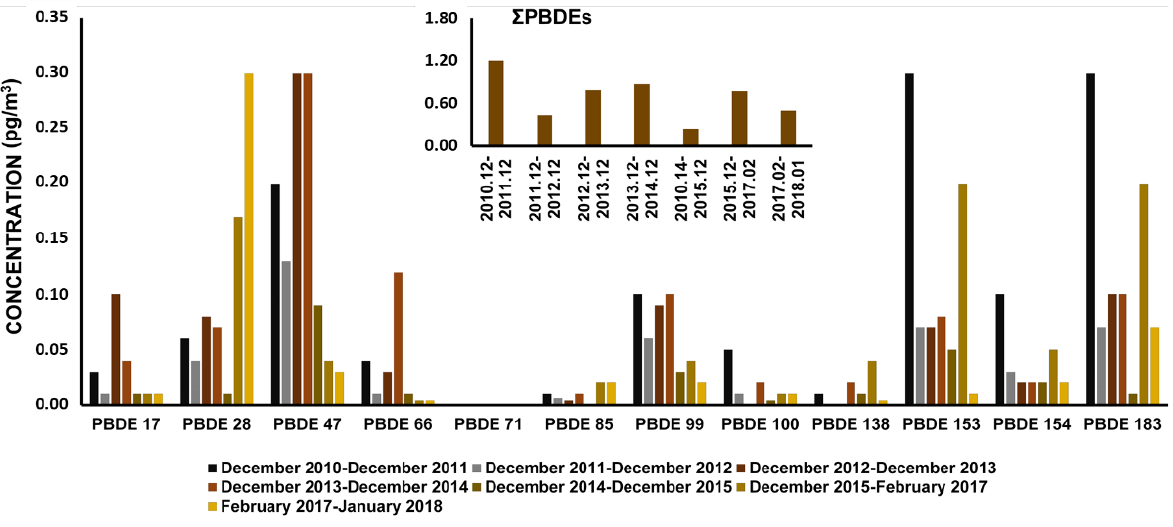
Figure 4. Temporal profile of PBDE congeners between December 2010 and January 2018. Own elaboration using pollution PBDE data from Hao et al., 2019 (study conducted at King George Is- land).